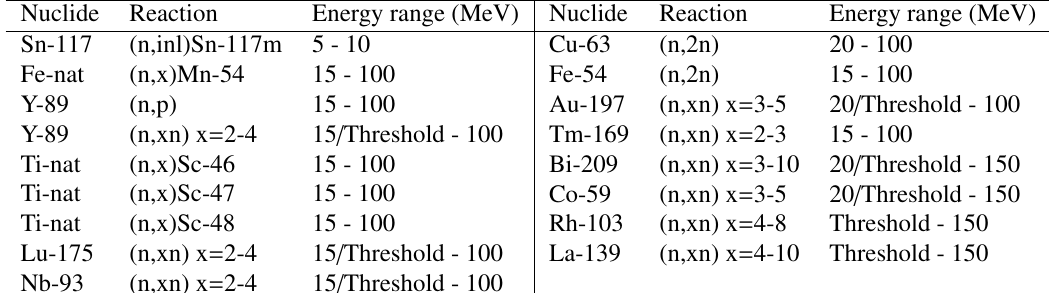
Table 7. Recent requests for improvement of cross sections relevant to the dosimetry of neutron